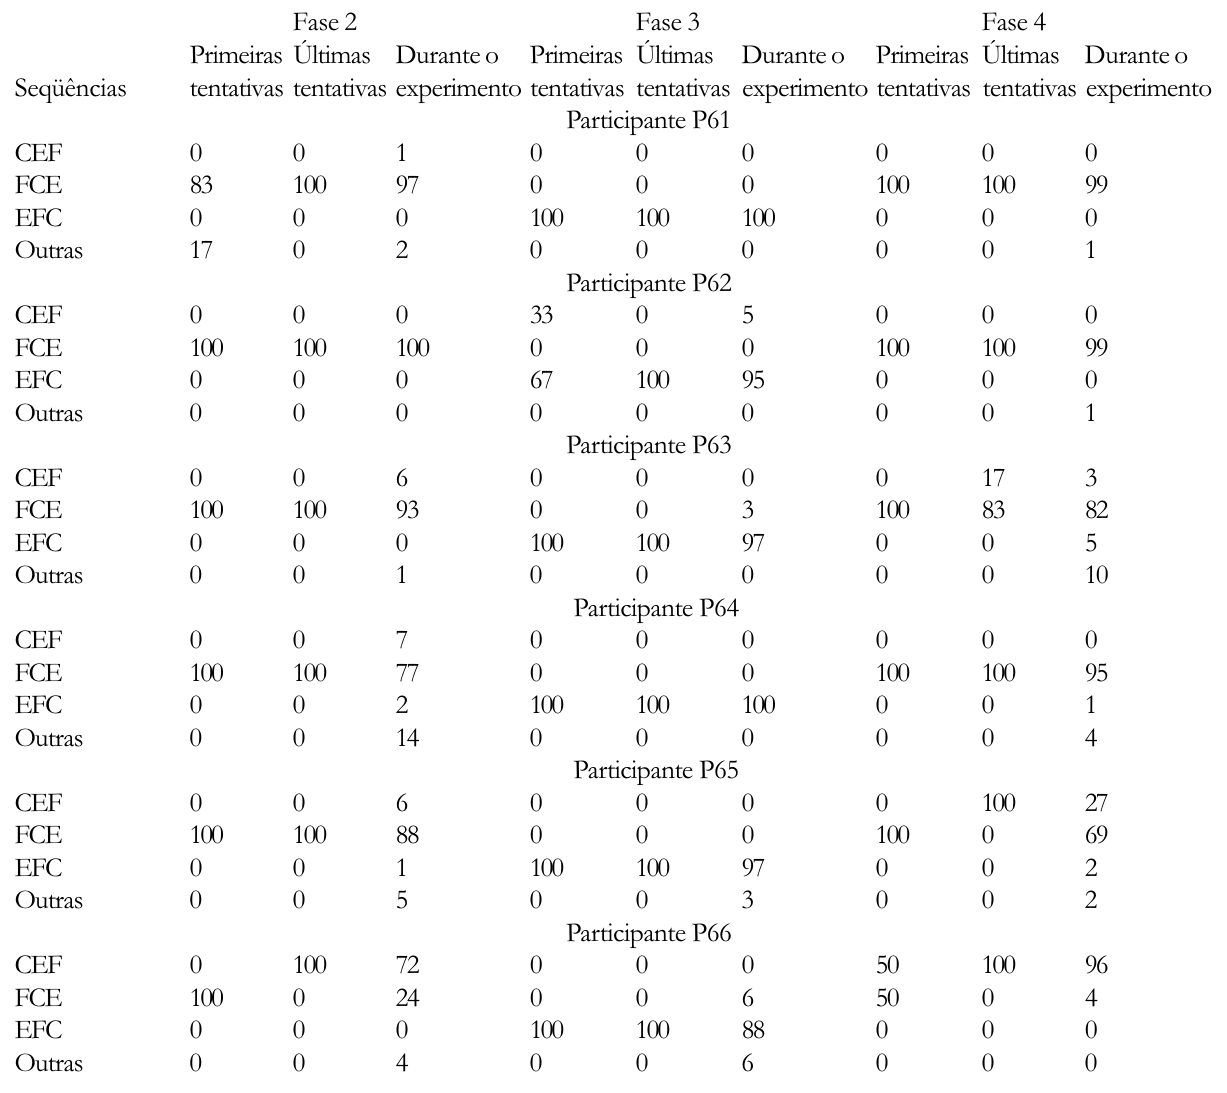
disso, apenas os dados dos participantes que atingiram o critØrio A Figura 2 mostra a freq(cid:252)Œncia acumulada de seq(cid:252)Œncias de encerramento da Fase 1 serªo considerados para anÆlise. de respostas corretas e incorretas, emitidas por cada Como na condi(cid:231)ªo precedente, as curvas da Figura 2 subsidiarªo participante da Condi(cid:231)ªo FR 6, durante as fases a que foram as anÆlises quantitativas apresentadas nas Tabelas 2, 3 e 5. expostos. Pode-se observar que dos 8 estudantes dessa Na Tabela 2 pode-se observar que 5 participantes (P 61, P condi(cid:231)ªo, 6 (P 61, P 62, P 63, P 64, P 65 e P 66) atingiram o critØrio de encerramento da Fase 1 e foram expostos (cid:224)s Fases 2, 3 e 4. Os 2 restantes (P 67 e P 68) nªo atingiram o critØrio de encerramento da Fase 1 e, portanto, nªo foram expostos (cid:224)s fases subseq(cid:252)entes. P 68 pediu para nªo mais continuar participando do experimento no final da 5“ sessªo da Fase 1. Em fun(cid:231)ªo Porcentagens de Seq(cid:252)Œncias de Respostas Emitidas pelos Participantes da Condi(cid:231)ªo FR 6 nas seis Primeiras e seis (cid:218)ltimas Tentativas, e Durante Toda a Fase Experimental, nas Fases 2, 3 e 4